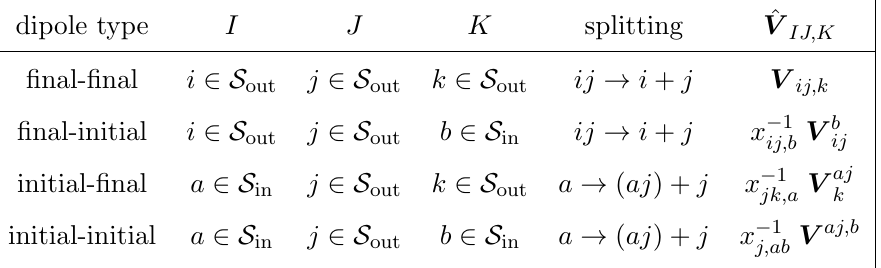
V IJ;K of (A.1) and the kernels and i; j; k . 2 S in 2 S out , corresponds 2 S out